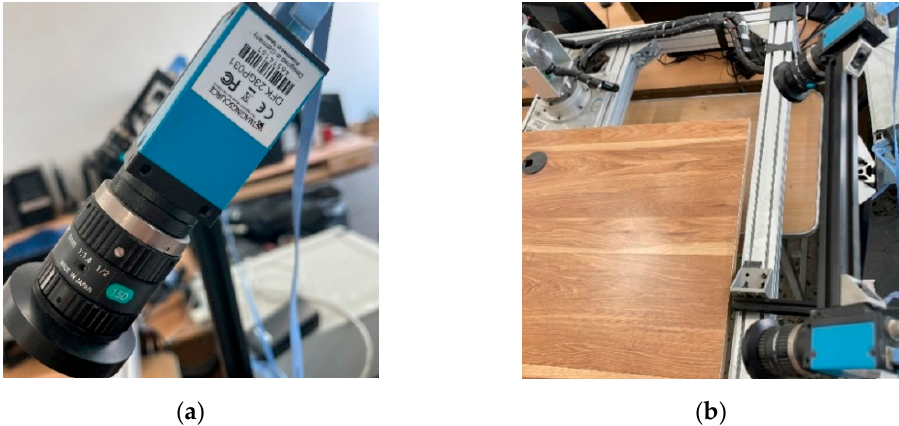
Figure 7. The image acquisition system: ( a ) DFK 23GP031industrial camera; ( b ) image acquisition system architecture.